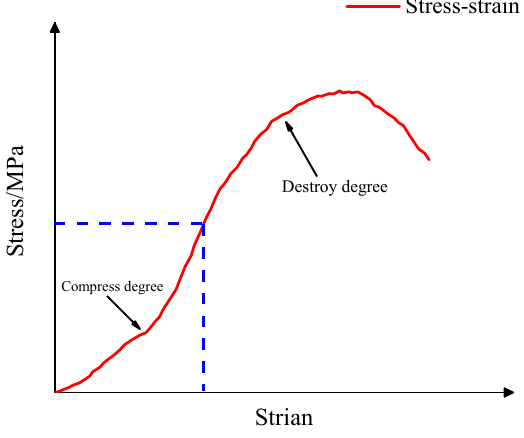
Figure 11. Different degrees of BFRCS in the loading process.